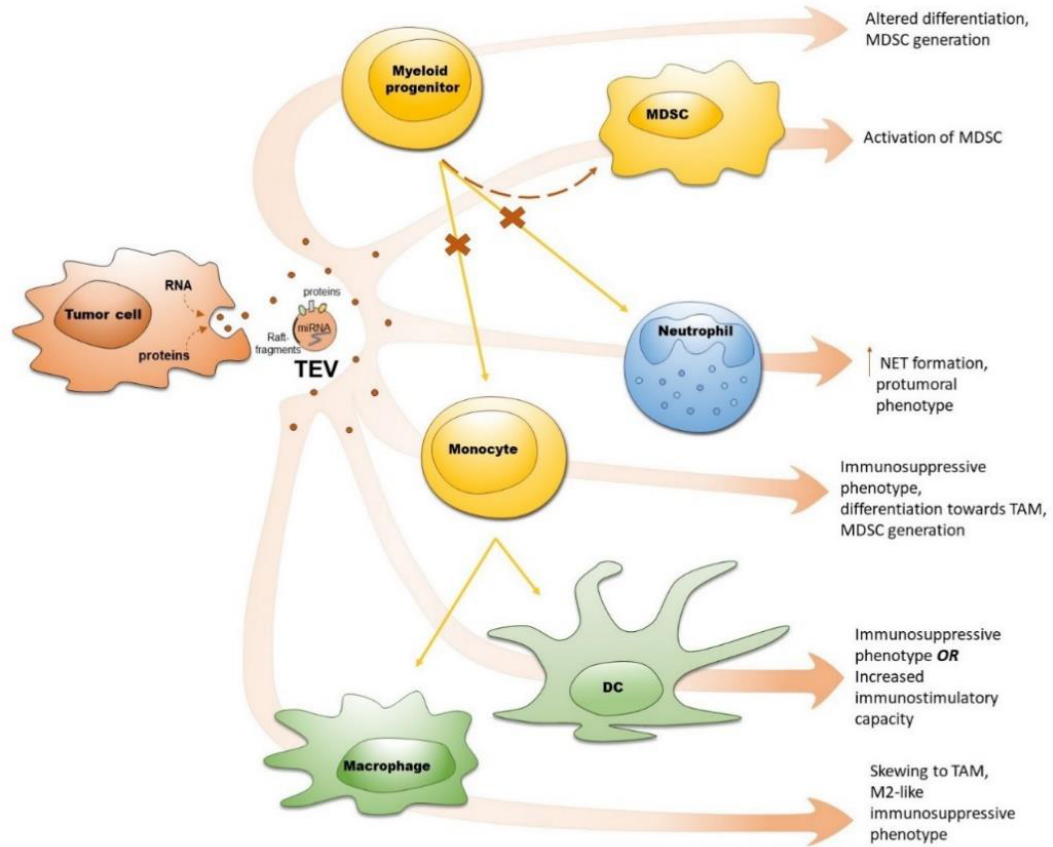
Figure 2. Tumor-derived extracellular vesicles (TEV) affect myeloid cell differentiation and function. Tumor cells secrete TEV containing tumor-derived factors (proteins, mRNA, miRNA etc.), which interact with myeloid progenitors (partially blocking their differentiation to mature myeloid cells that is shown with “x”), monocytes, neutrophils and myeloid-derived suppressor cells (MDSC), resulting in tumor-promoting immunosuppression (shown with arrows). Exposure of dendritic cells (DC) to TEV leads to either acquisition of immunosuppressive function or induction of immunostimulatory capacity (shown with arrows).